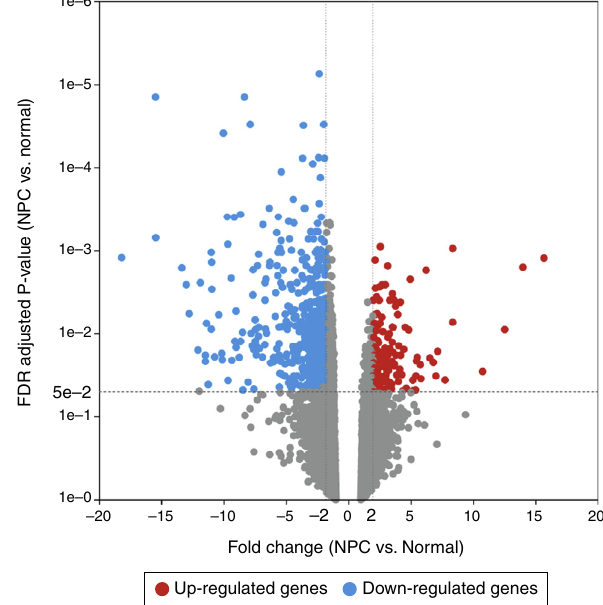
The volcano plot for differentially expressed genes (DEGs) (FC > 2 and adjusted p -value < 0.05). The horizontal axis represents the fold change, and the vertical axis represents the adjusted p -value. The red and blue circles indicate up- and down-regulated genes, respectively.